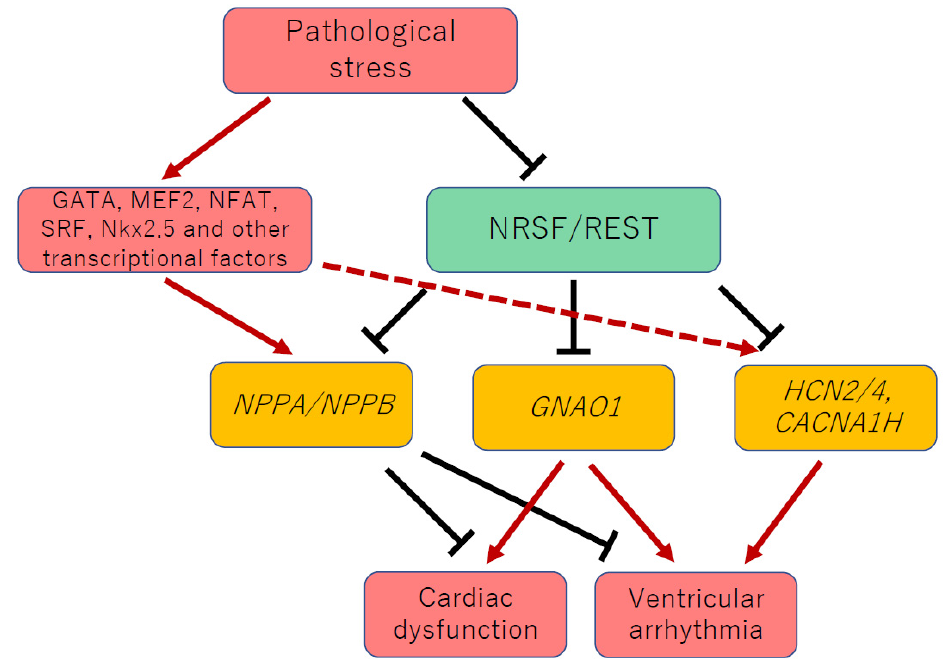
Figure 1. NRSF maintains normal cardiac function and electrical stability by regulating the cardiac gene program with other transcription factors. Whereas ANP and BNP protect against heart failure development, reactivation of G α o and fetal-type cardiac ion channels, such as T-type Ca 2+ and HCN channels, leads to cardiac dysfunction and ventricular arrhythmia in dnNRSF-Tg mice and NRSF cKO mice. HCN, hyperpolarization-activated cyclic nucleotide; NFAT, nuclear factor of T cells; MEF2, myocytes enhancer factor 2; SRF, serum response factor; NRSF, neuron-restrictive silencer factor; REST, repressor element-1 silencing factor.